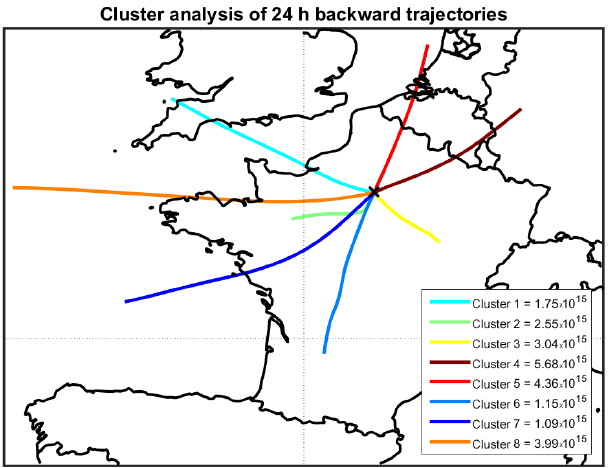
Figure 10. Cluster analysis of 24h backward trajectories arriving in spring in Paris (from 15 February to 15 May for the 2013– 2016 period) using HYSPLIT-4 model obtained from the NOAA Air Resources Laboratory. Mean trajectories of the eight clusters are shown in different colours, associated with the NH 3 concentra- tions measured by IASI in the IdF region (in moleculescm − 2